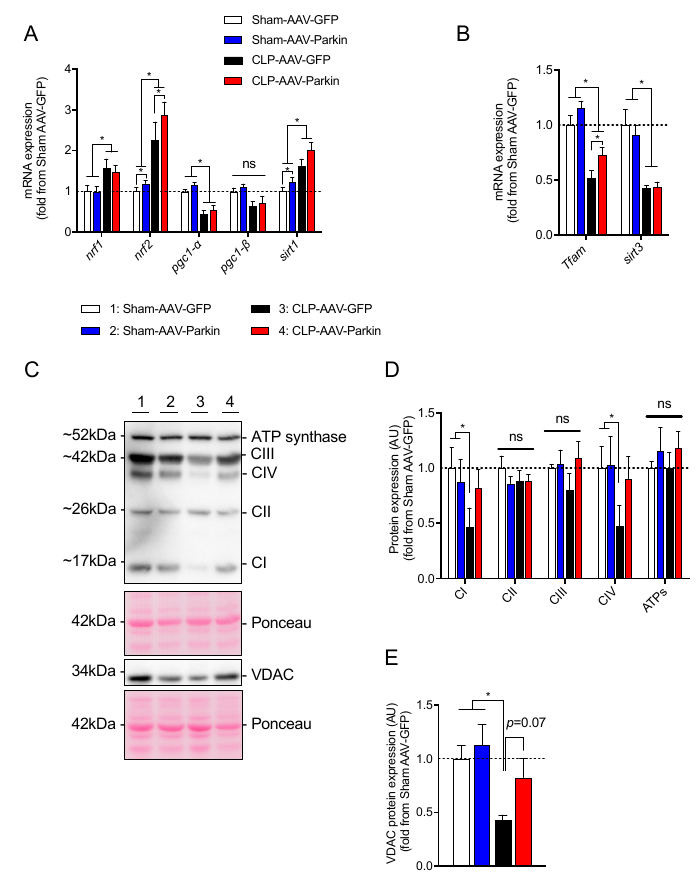
Figure 4. The impact of Parkin overexpression and sepsis in skeletal muscle on genes regulating mitochondrial biogenesis and on mitochondrial protein contents. ( A , B ) qPCR analysis of genes involved in mitochondrial biology. ( C ) Representative immunoblots performed with primary antibodies against representative subunits of the OXPHOS complexes and VDAC. Ponceau stains were used as loading controls. ( D , E ) Quantification of the contents of ( D ) representative subunits of the OXPHOS complexes and ( E ) VDAC. 1 = Sham-AAV-GFP; 2 = Sham-AAV-Parkin; 3 = CLP-AAV-GFP; 4 = CLP-AAV-Parkin. Data are presented as mean ± SEM. ( n = 6–9 / group, * = statistically significant; ns = not statistically